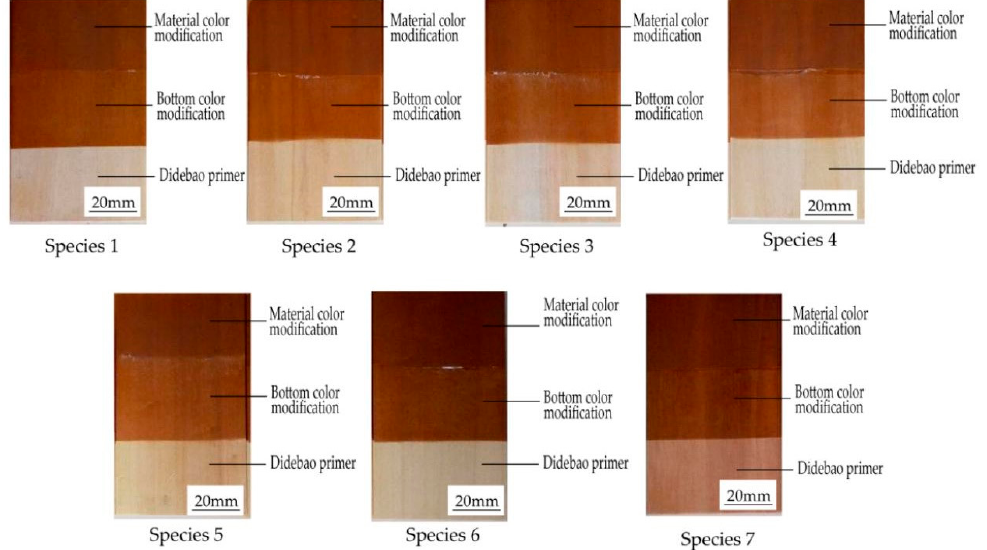
Figure 1. Coloring effect of test piece by area.